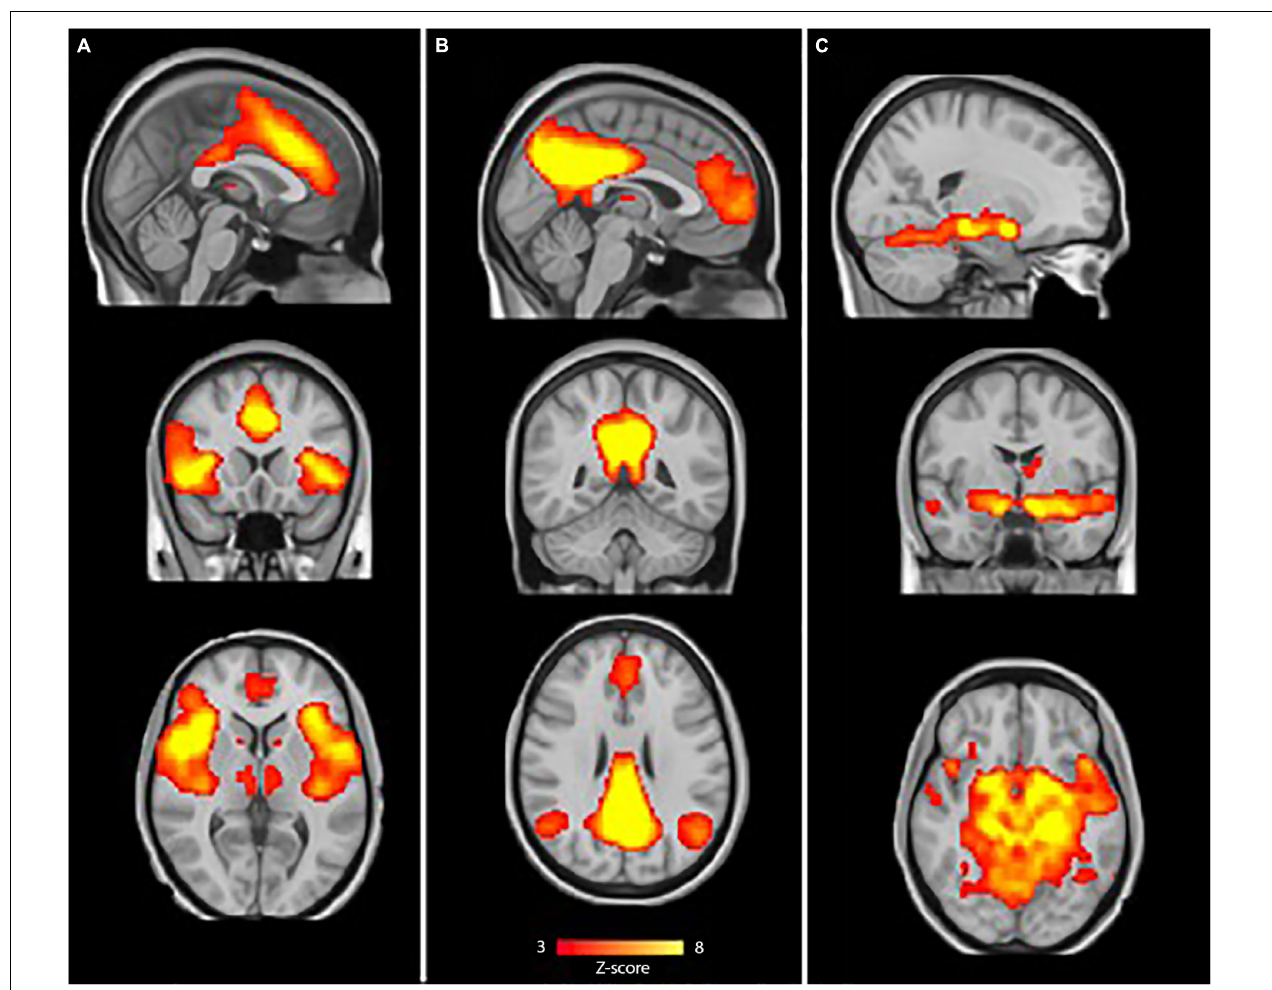
FIGURE 1 | Resting-state networks of interest. The sample-specific selected components for: (A) Salience network (SN), (B) default-mode network (DMN) and (C) . Limbic network. The color bar depicts Z-scores and runs from red ( Z = 3) to yellow ( Z =